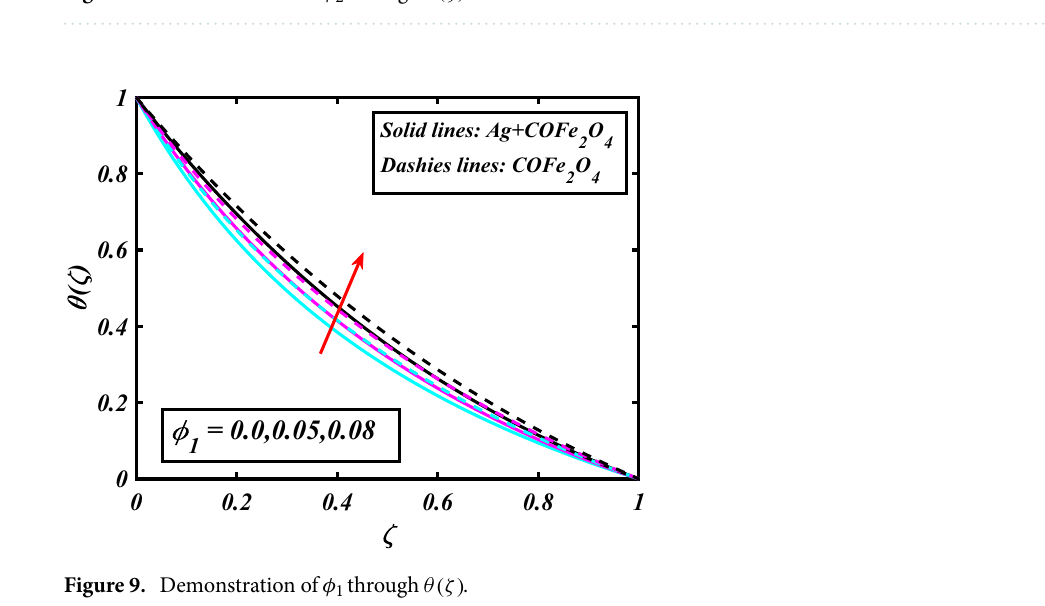
Figure 8. Demonstration of φ 2 through θ(ζ) .